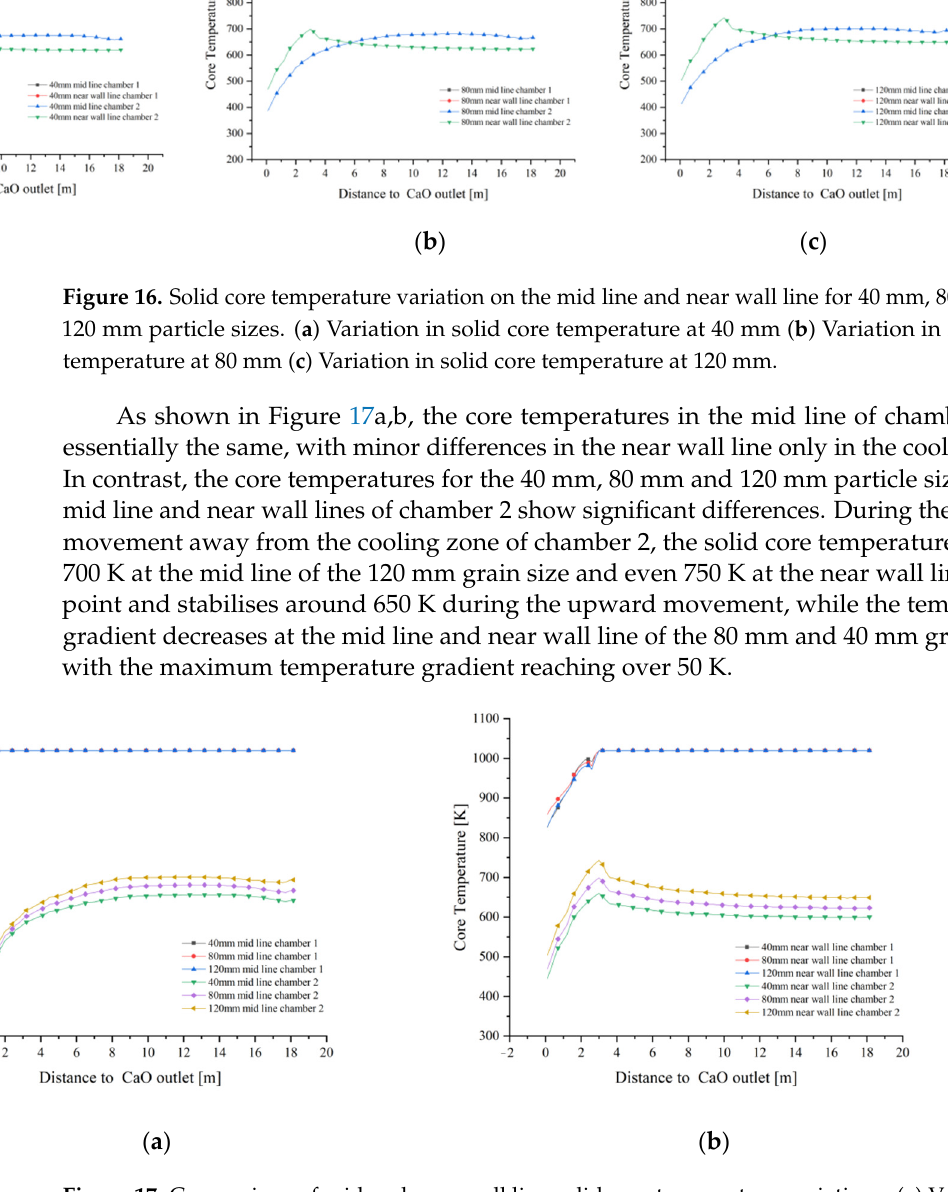
Figure 17. Comparison of mid and near wall line solid core temperature variations. ( a ) Variation in solid core temperature at the mid line ( b ) Variation in solid core temperature at the near wall line.